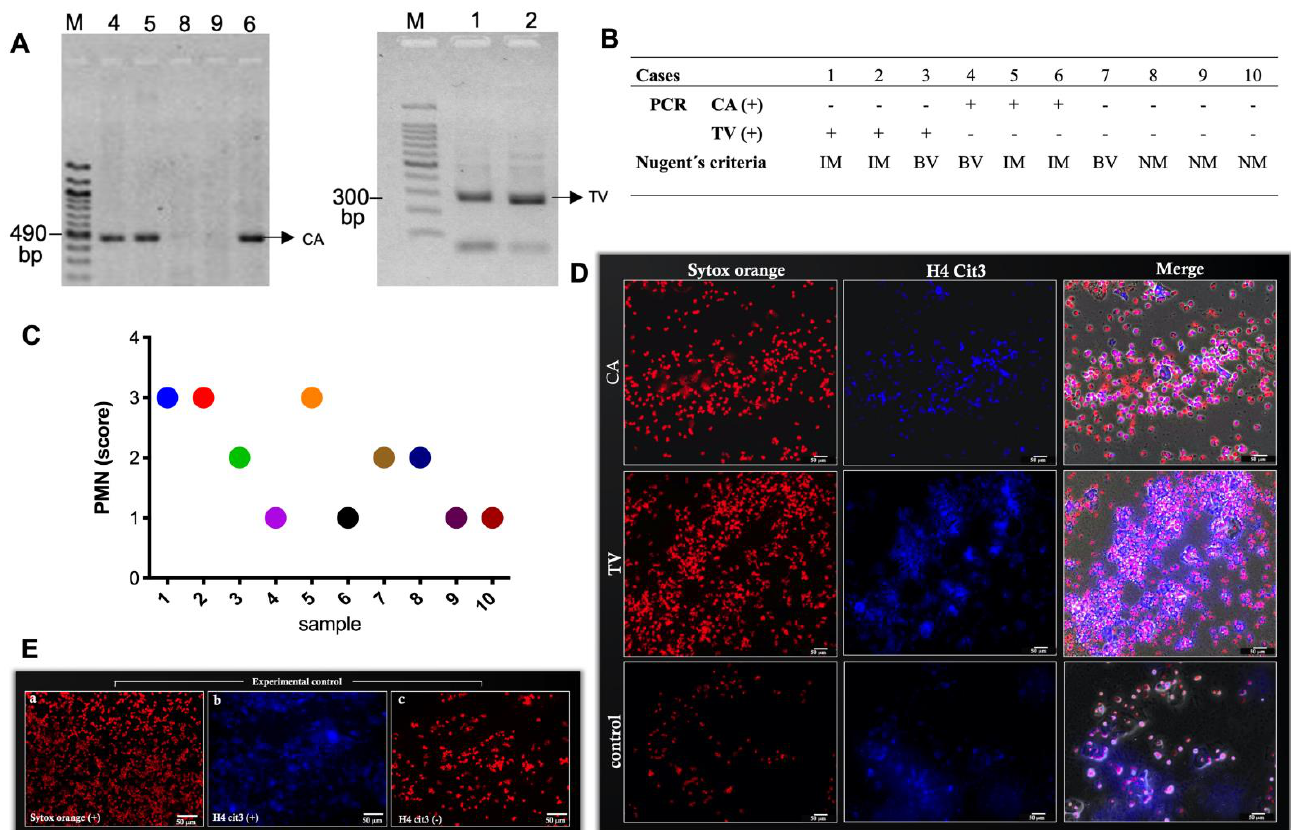
Figure 1. Diagnosis and characterization of vaginal discharges. ( A ) Representative images of the PCR results for the samples of vaginal discharges with CA and TV. ( B ) The results of each case in the PCR diagnosis and the classification according to Nugent’s criteria (NM, normal microbiota; IM, intermediate microbiota; BV, bacterial vaginosis). ( C ) The score for the presence of neutrophils in each vaginal discharge (pathological and controls), with 1 indicating scarce, 2 indicating moderate, and 3 indicating abundant. ( D ) Representative images of epifluorescence microscopy showing neutrophil infiltration in vaginal discharges for CA, TV, and control group. Red indicates DNA (Sytox Orange) and blue indicates H4cit3; the merge was done in a bright field. Images in ( E ) show experimental controls: ( a ) Sytox-orange-positive cells, ( b ) H4cit3-positive cells, and ( c ) H4cit3-negative cells (without primary antibody). The images were taken at 20× magnification.